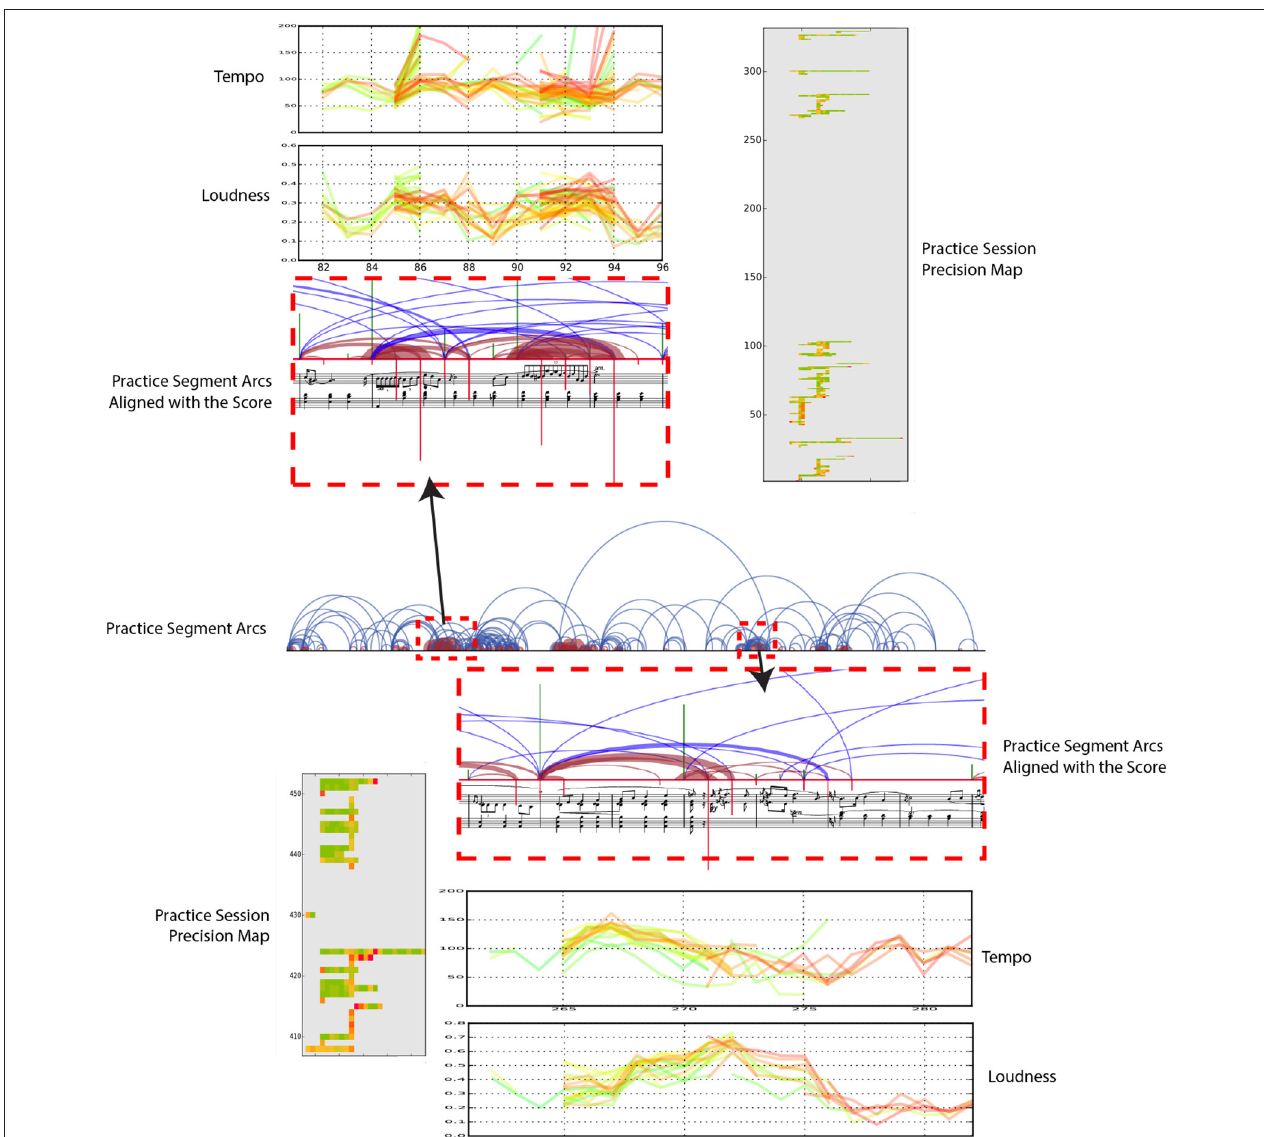
FIGURE 7 | Tempo-Loudness Evolution Graphs (top left and bottom right) for expert player (E-1). Green lines depict tempo/loudness at beginning, progressively turning to red by end, of practice session. The x-axis marks the time within the piece (score time). Also shown are Practice Segment Arcs and Practice Session Precision